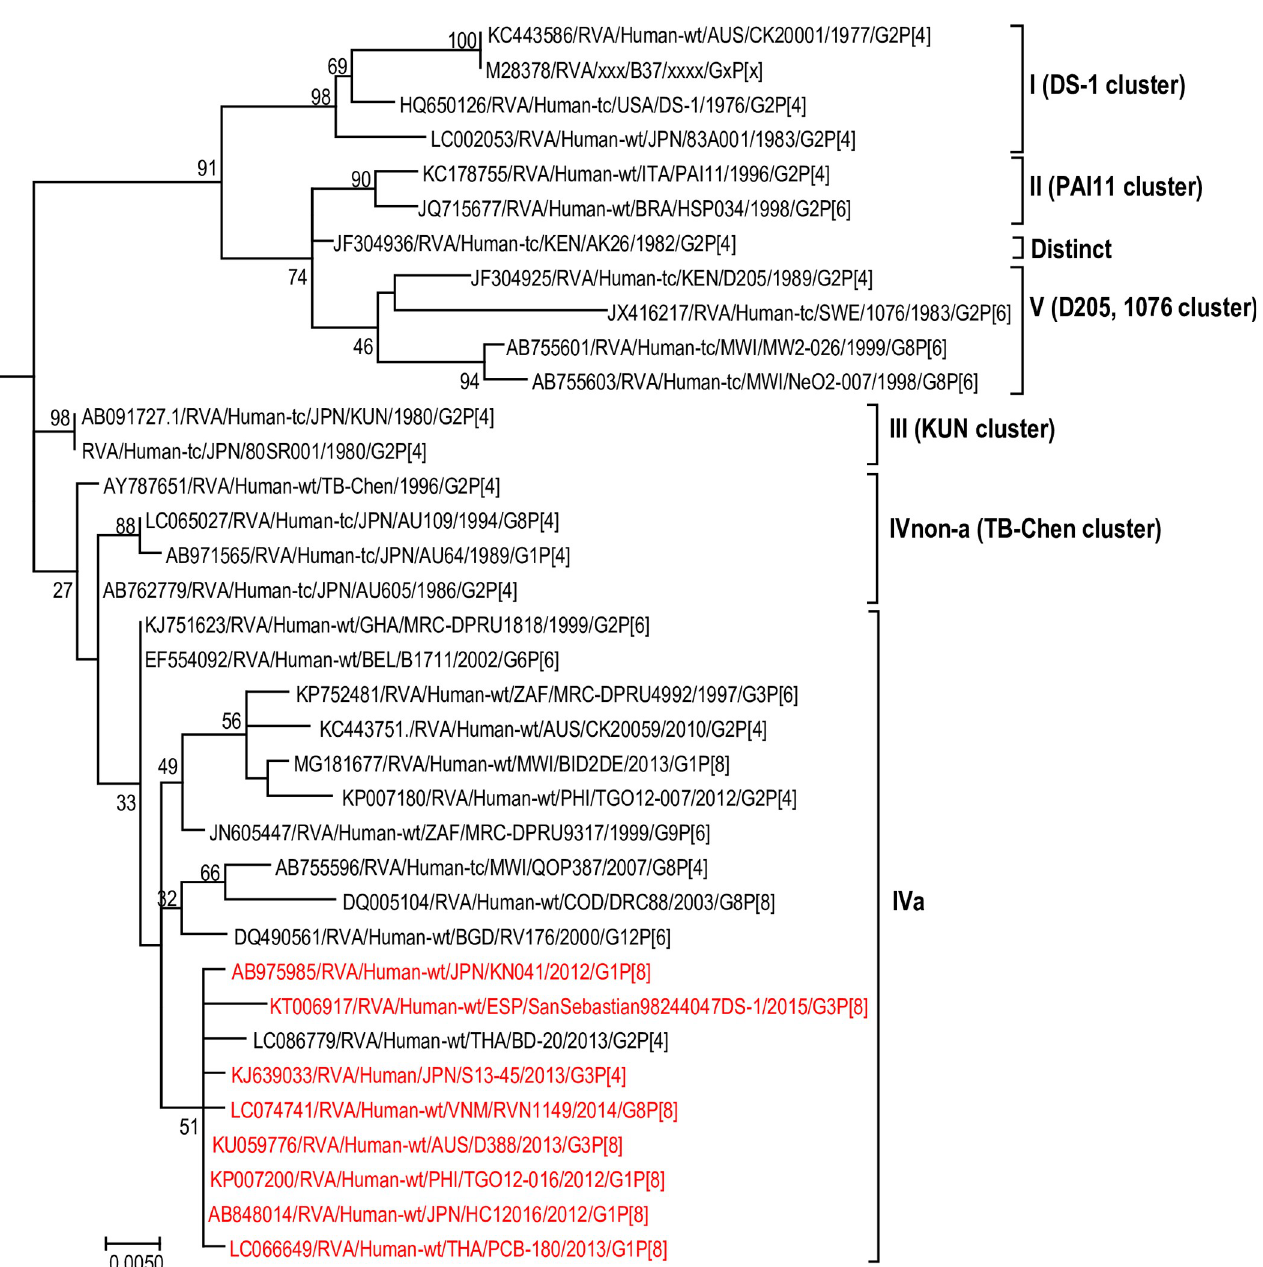
Fig 10. Reference phylogenetic lineage designation for the NSP4-E2 genotype of RVA strains of human and animal host species origin. Phylogenetic tree was constructed using the maximum likelihood method with 1000 bootstrap replicate trials. The tree was rooted using the NSP4-A1 gene of the genotype 1 prototype strain Wa. “Hybrid lineages” containing a mixture of human and animal RVA sequences are indicated with § in addition to the lineage number. Representative unusual emerging reassortant strains whose lineage constellations were determined in this study using the newly established phylogenetic framework are indicated in red font. Scale bar at the bottom of the tree represents genetic distance expressed as nucleotide substitutions/site.